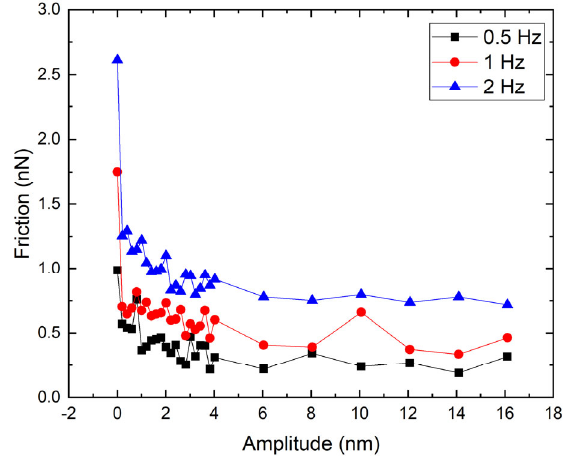
Fig. 4 Friction detected by scanning and z -directional vibration excitation on the HOPG surface as a function of the amplitudes (0–16 nm) for the different scanning speeds (0.5, 1, and 2 Hz).